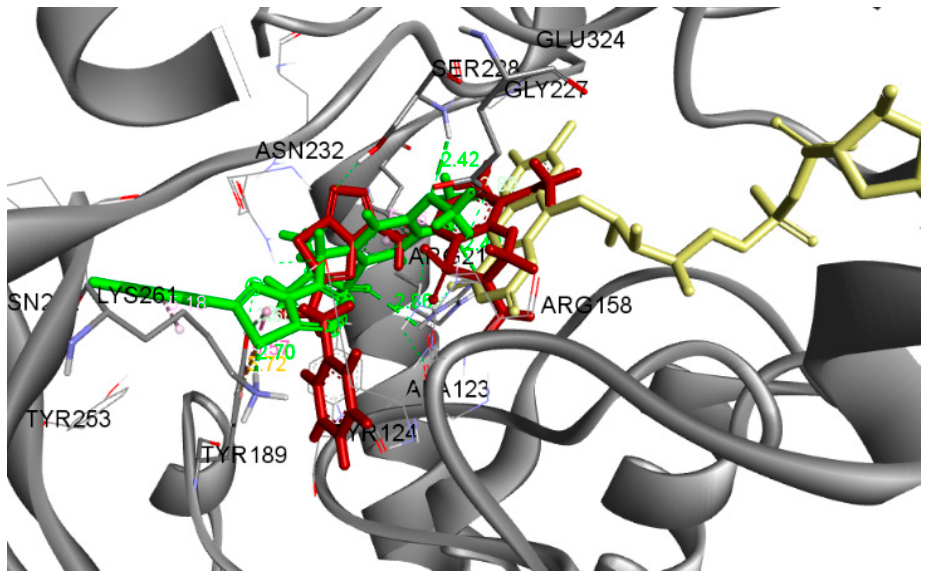
Figure 2. Docked conformation of compounds 19 (green), 3 (red), and FAD (yellow) in E.coli MurB.